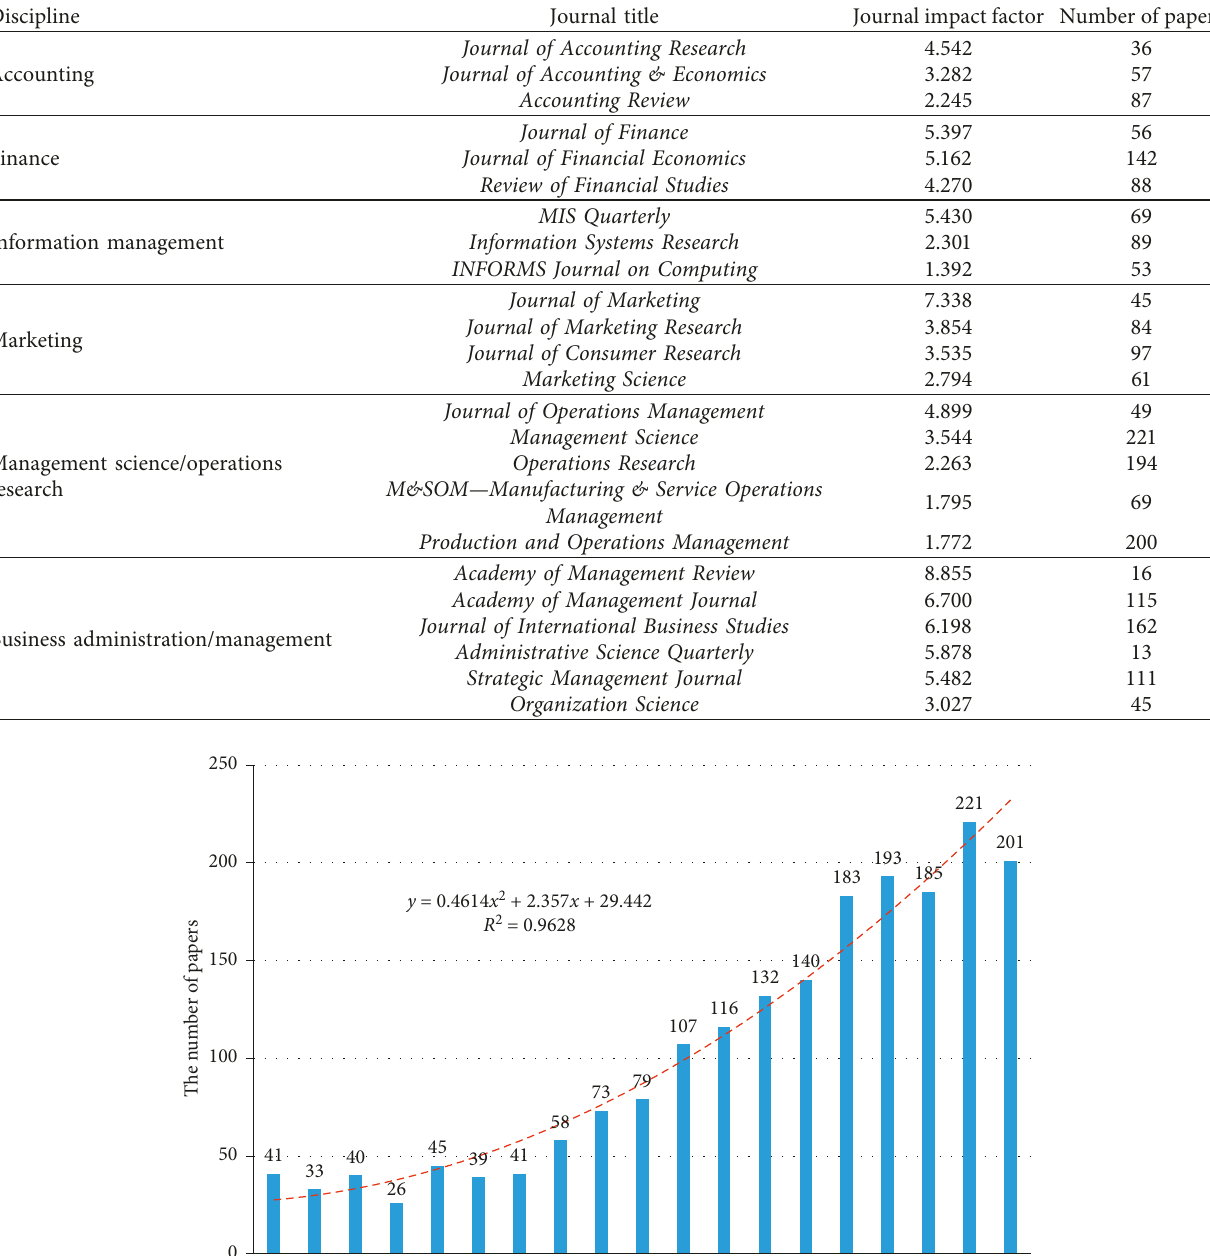
Table 1: Journal name and impact factor of UTD24 and number of papers published by Chinese busines schools from 2000–2018. Discipline